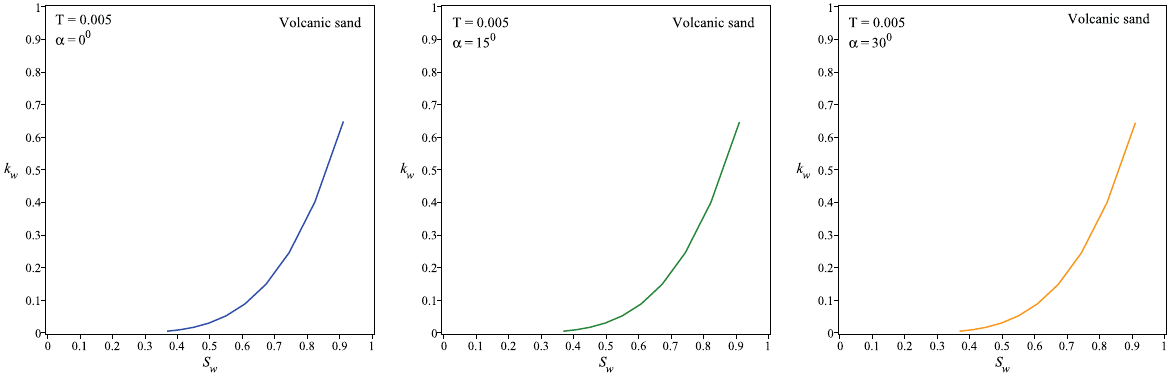
Fig. 8: Relative permeability vs. Saturation in Heterogeneous Porous Media for Volcanic Sand at different inclined plane α = 0 ◦ , 15 ◦ , 30 ◦